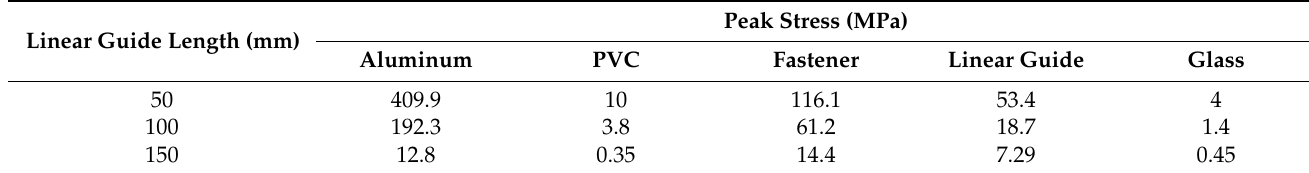
Table 10. Peak stress applied to each member.